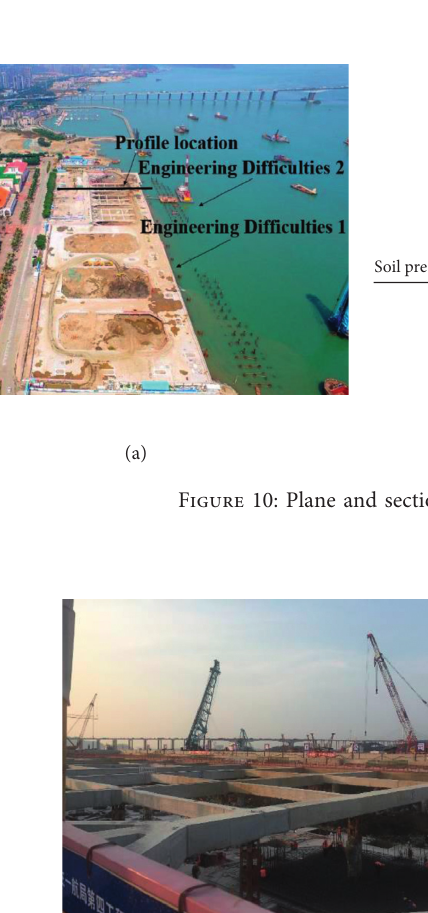
Figure 9: Environmental map of the foundation pit surroundings.